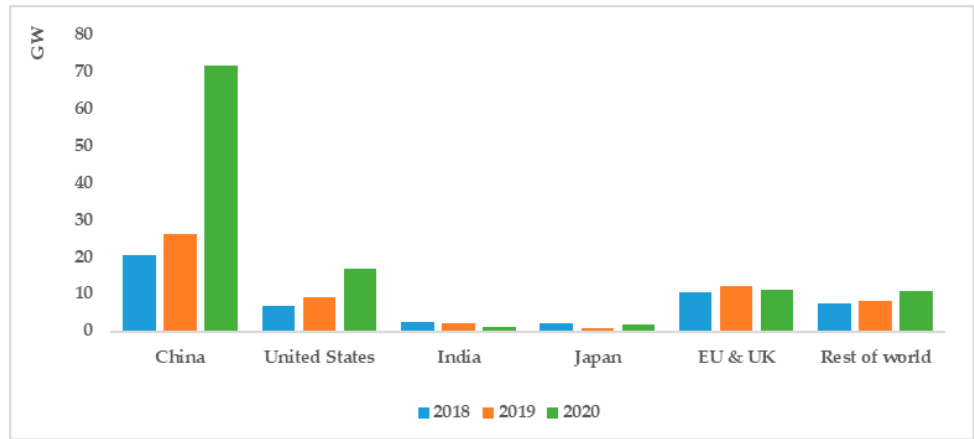
Figure 1. Global net annual increase in wind power generation 2018–2020